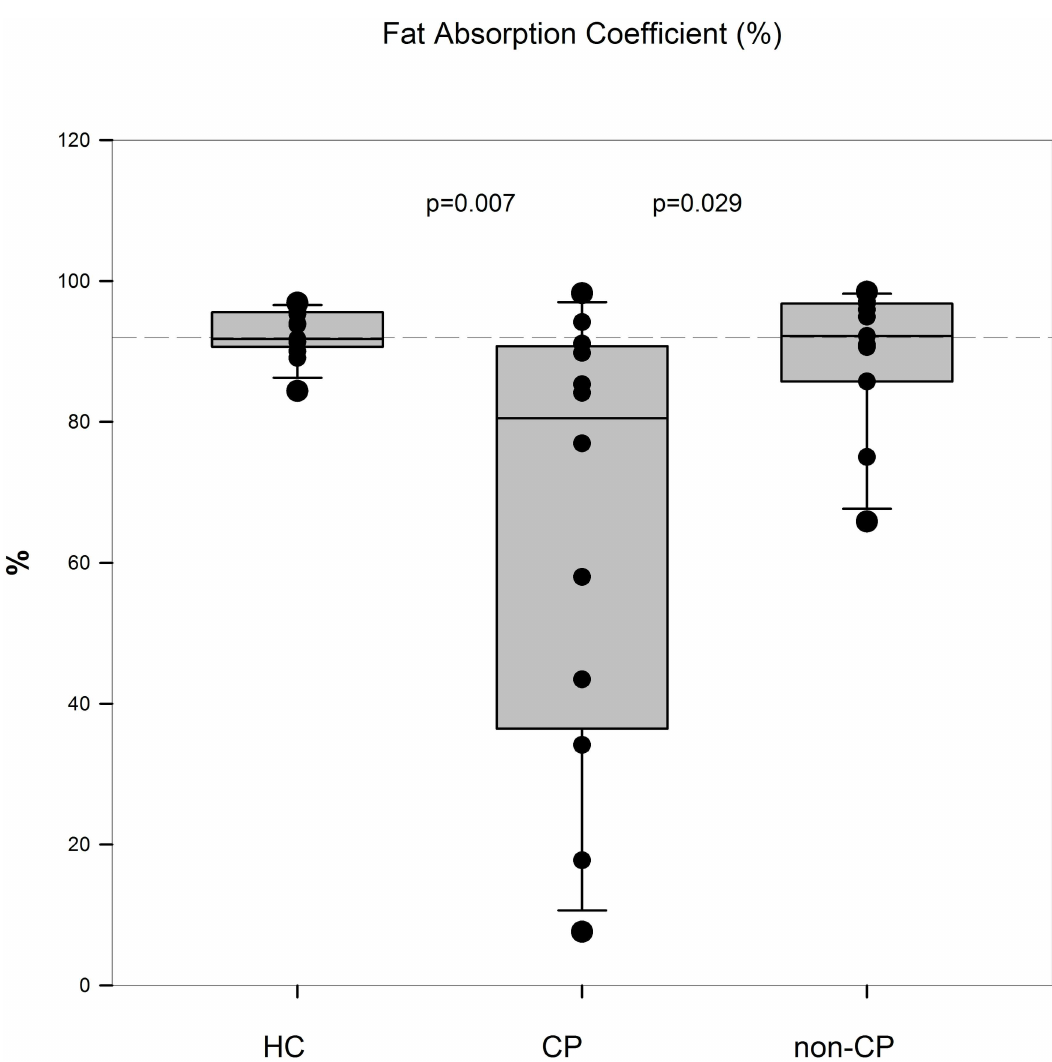
Fig 6. Coefficient of fat absorption. Generallyacceptedcut off is 90% (dashedline). Reciprocalresults as in “A” indicate no additionalinformationof fat absorption.CP patients have significantlower fat absorptionthan healthy controls and